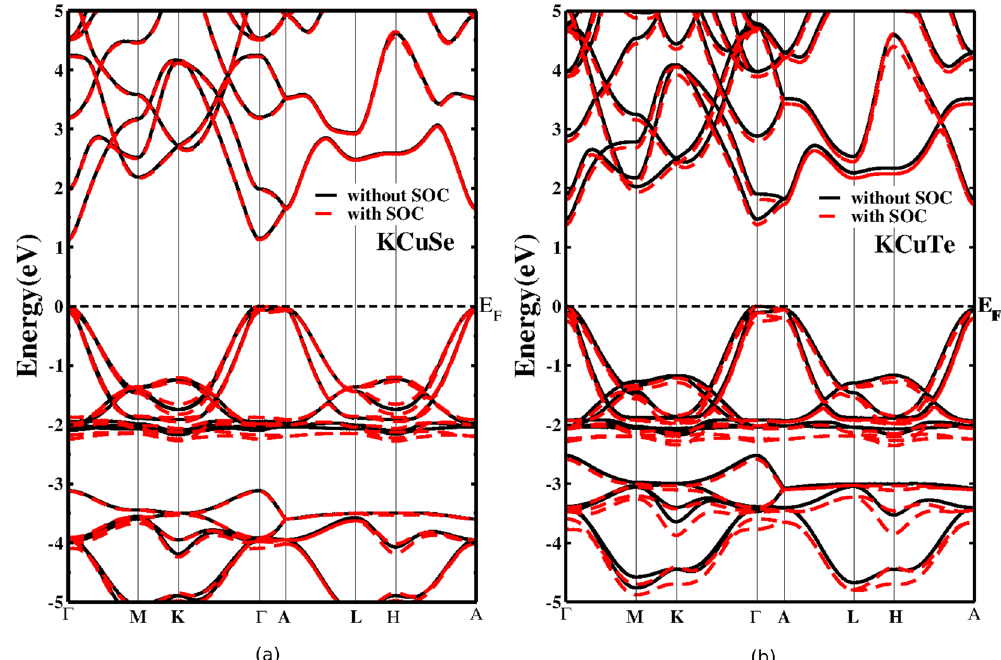
Figure 3. Calculated electronic band structure of optimized crystal at ambient conditions using TBmBJ potential without and with spin-orbit coupling for ( a ) KCuSe and ( b ) KCuTe with the Fermi level fixed to